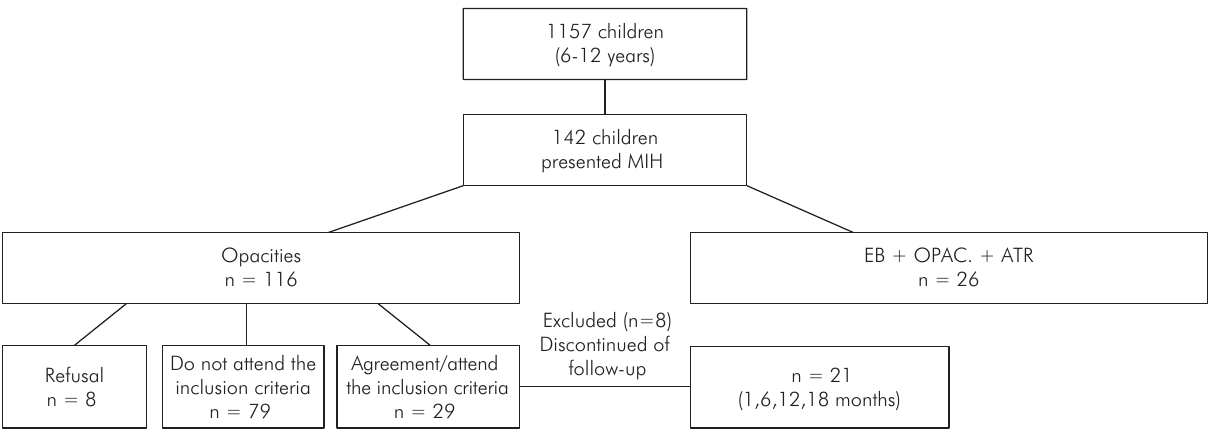
Figure 1. Number of subjects of the study. OPAC, opacities; EB, enamel breakdown; ATR, atypical